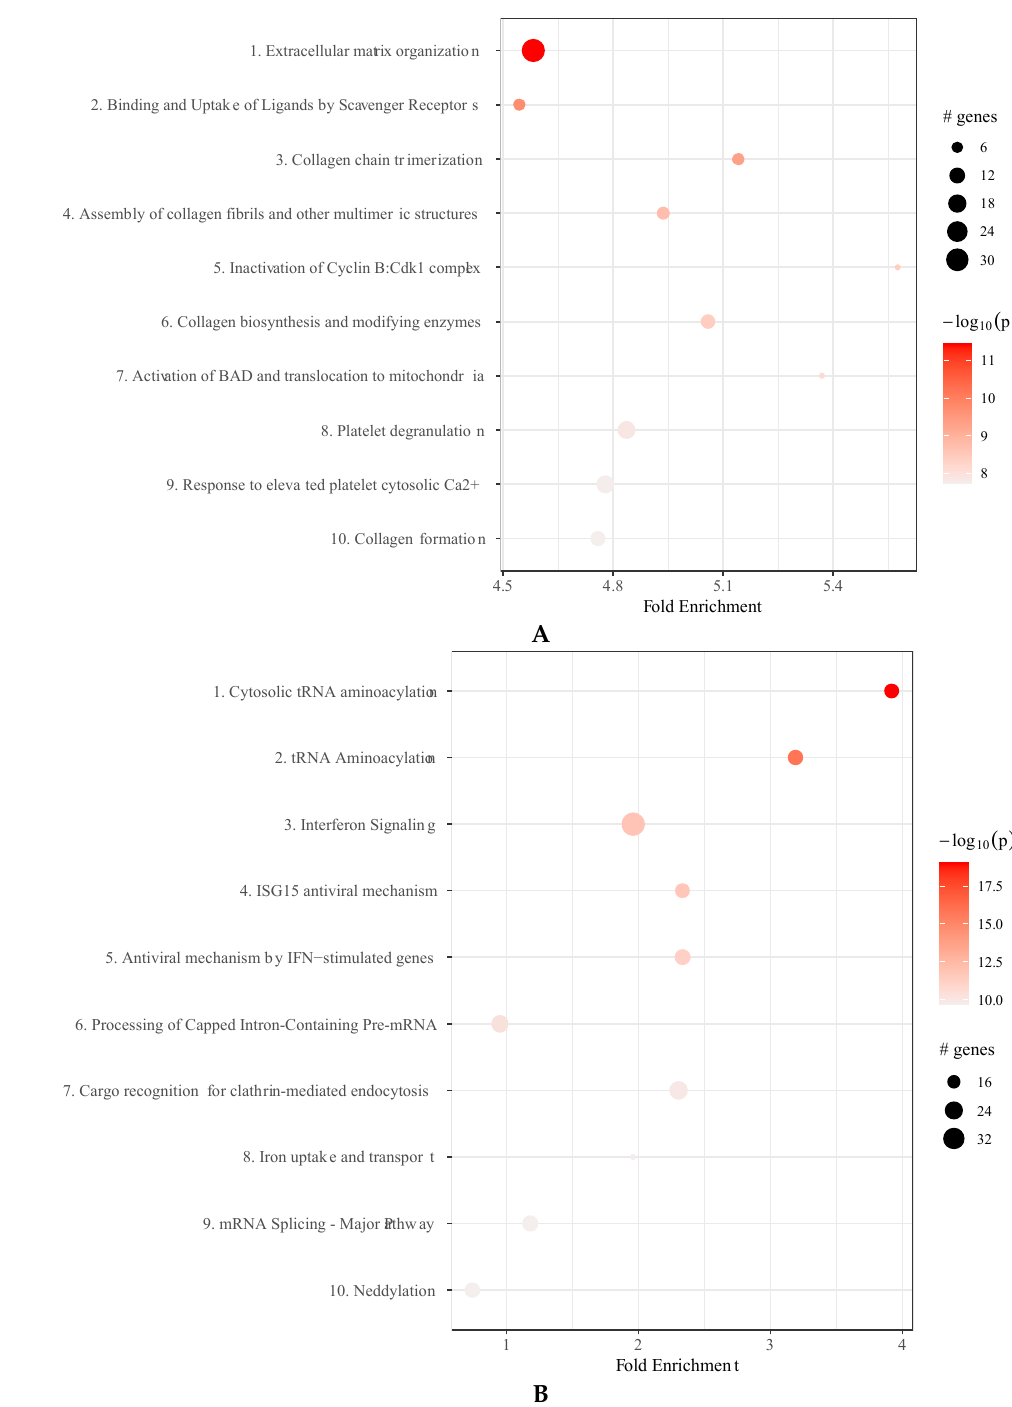
Figure 5. Pathway analysis. ( A ): Bullet chart displaying enriched pathways in EV γ compared to EV. Size of the bullets indicates the number of proteins in the given enriched pathway. Color indicates the − log10(lowest p -value). ( B ): Bullet chart displaying enriched pathways in MP γ compared to MP after removal of proteasome and ribosome related pathways. Size of the bubble indicates the number of proteins in the given enriched pathway. Color indicates the − log10(lowest p -value).